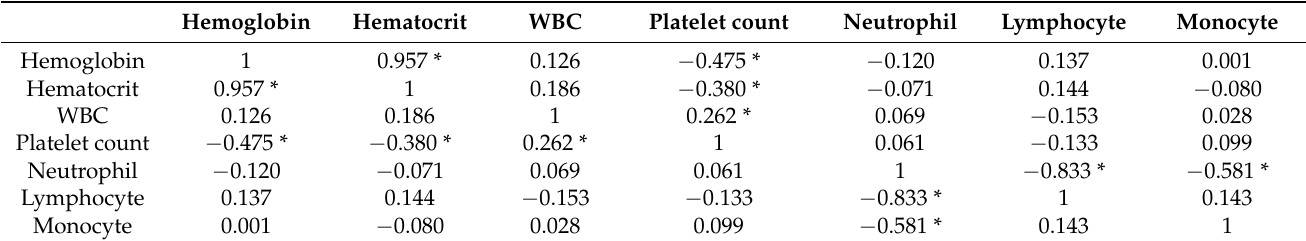
Table 2. The result of Spearman’s rank correlation test between the laboratory test parameters. Hemoglobin